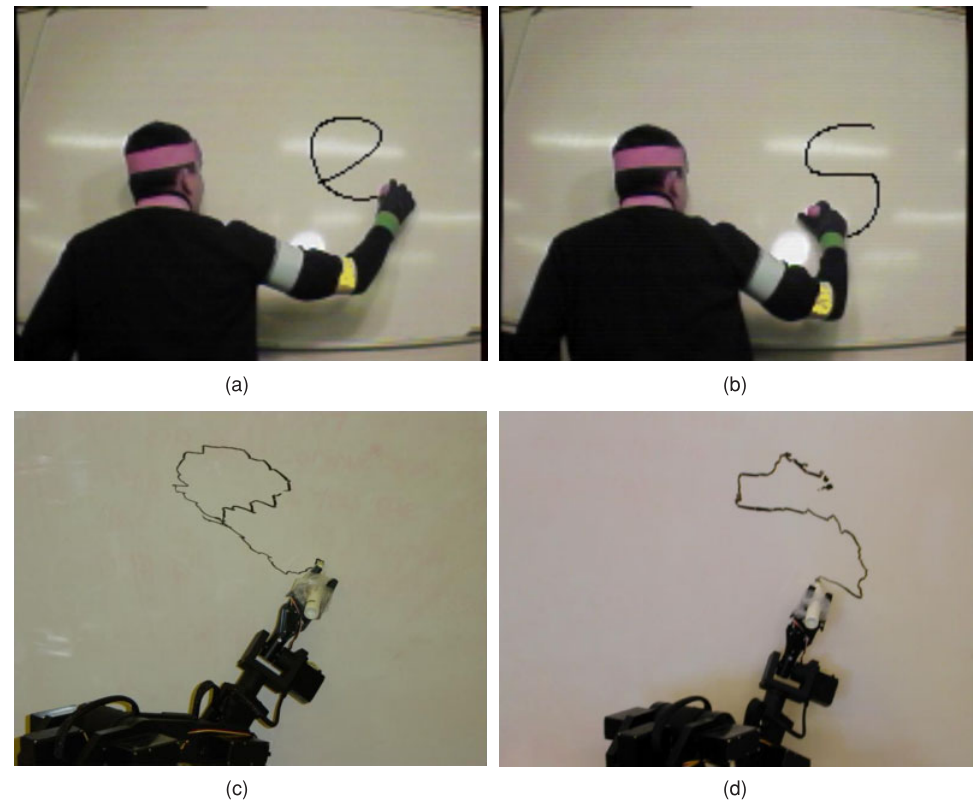
Figure 8 Learning phase, in (a) and (b) the demonstrator is writing the letters “e” and “s”. Execution phase, in (c) and (d) the robot is writing those